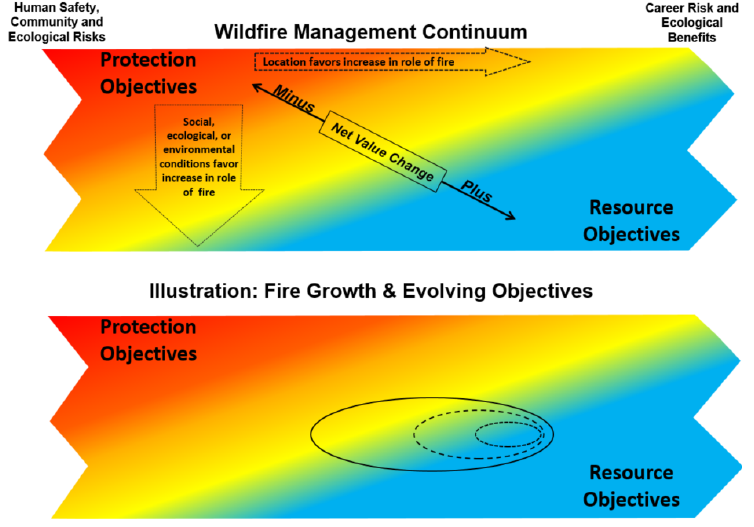
Figure 1. Conceptual Wildland Fire Management Continuum.